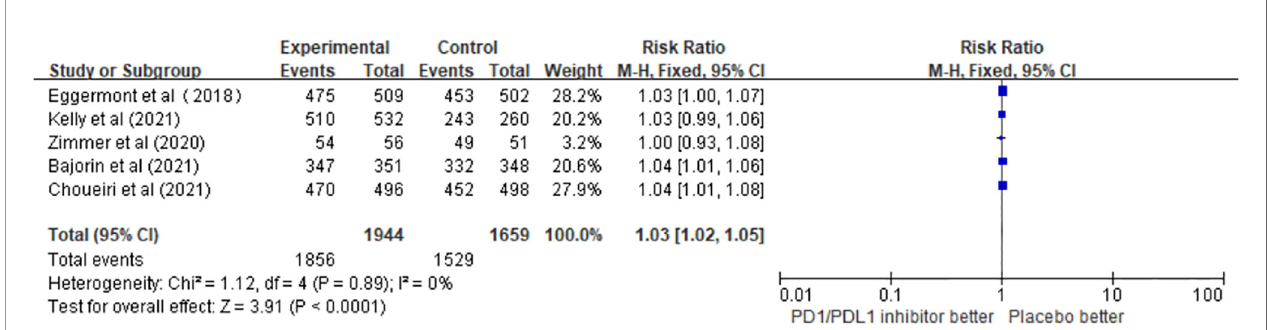
FIGURE 5 | The risk of any grade AEs in the PD1/PDL1 inhibitors groups and placebo